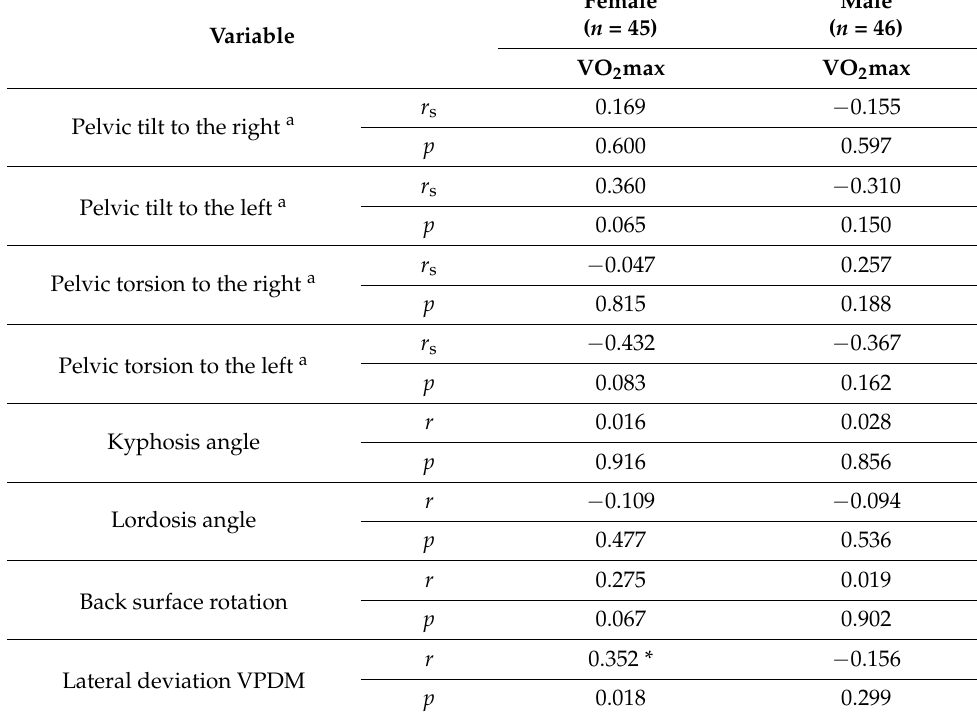
Table 6. Relationships between maximal oxygen uptake and pelvic position, angle of spinal kyphosis and lordosis, and body posture